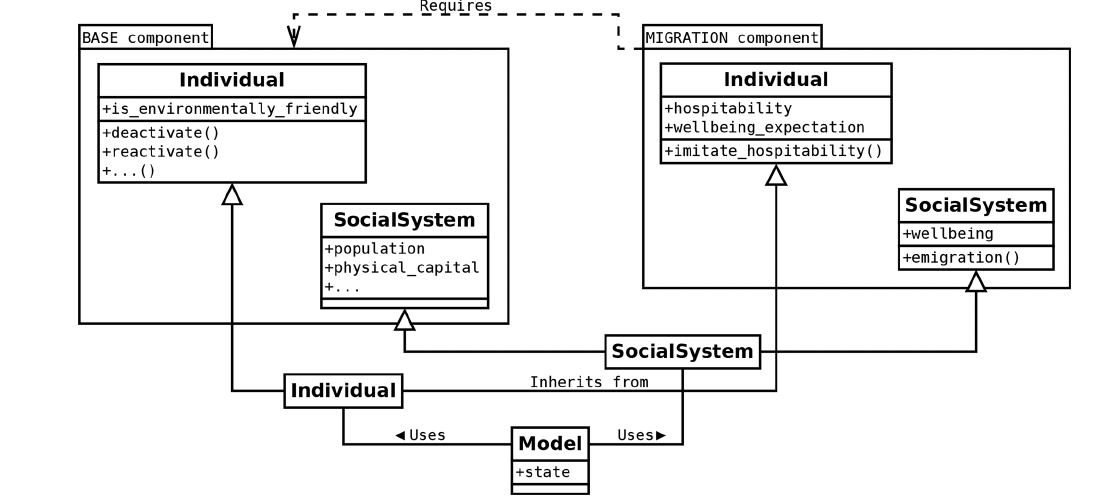
Figure 3. Model composition through multiple inheritance of attributes and processes by process taxa and entity types. This stylized class diagram shows how a model in copan:CORE can be composed from several model components (only two shown here: the mandatory component “base” and the fictitious component “migration”) that contribute component-specific processes and attributes to the model’s process taxa and entity types (only two shown here: “individual” and “SocialSystem”). To achieve this, the classes implementing these entity types on the model level are composed via multiple inheritance (solid arrows) from their component-level counterparts (so-called “mixin”